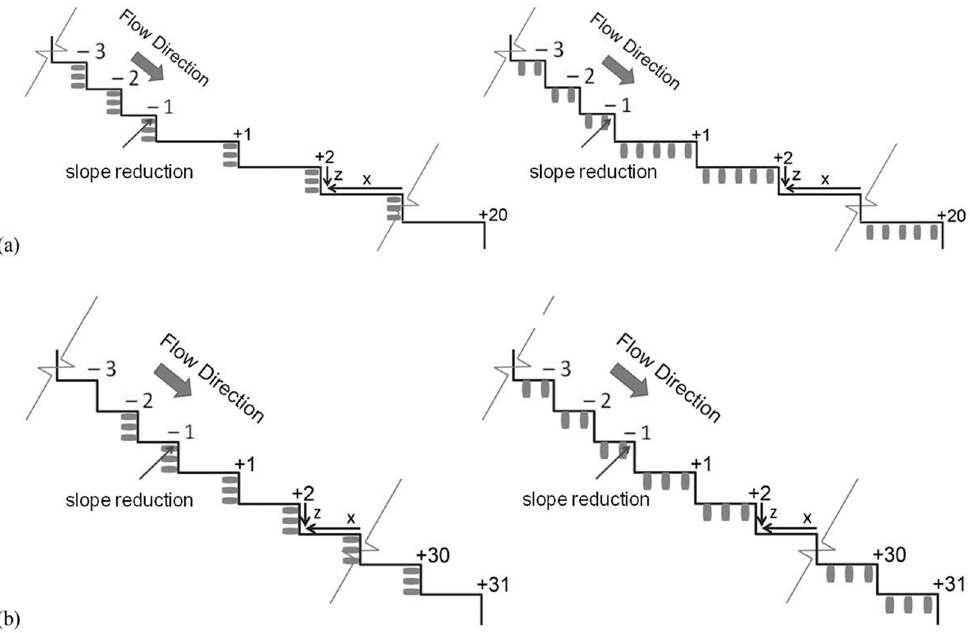
Figure 3. Pressure transmitter positions on the horizontal and vertical step faces, for ( a ) 50° to 18.6° and ( b ) 50° to 30° slope reduction. The step numbers downstream of the slope reduction are positive; otherwise, they are negative.